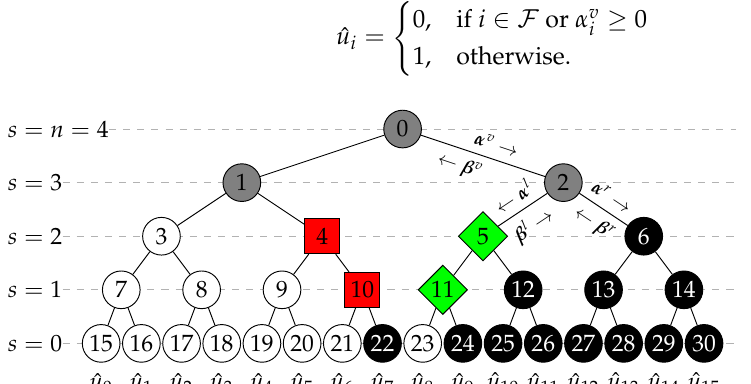
( 16,8 ) with u 0 , . . . , u 6 , u 8 Figure 1. Polar factor tree for . Rate-0, Rate-1, Repetition code P { } ∈ F (REP) and Single Parity-Check code (SPC) nodes with a node size restriction of N v ,max = 4 are represented as white and black circles, red squares and green rhombs,